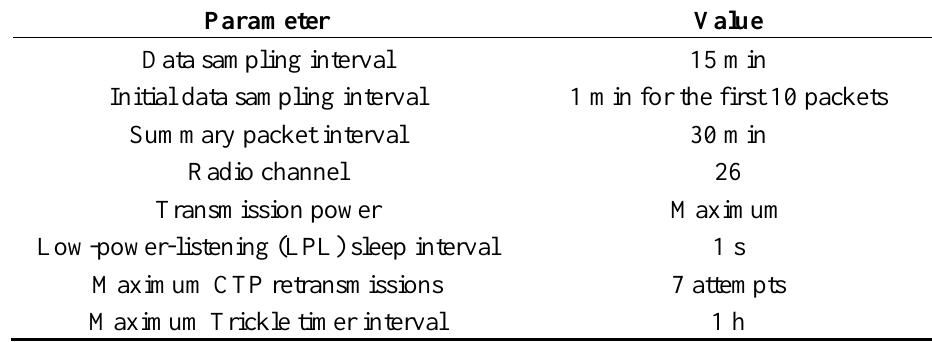
Table 2. Summary of non-default parameters configured in the CTP-based WSN application deployed at the ASWP